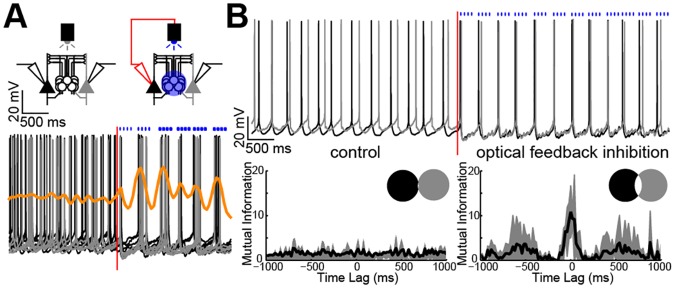
Type A PCs auto-synchronize via MCα2 inhibition.(A) Coupling one PC (black) out of two unconnected type A PCs to the light source/optical feedback inhibition system shows unsynchronized activity before and synchronized APs during optical feedback inhibition. A total of 24 PC discharges pairwise aligned to the first PC AP with optical feedback inhibition are shown (n = 24 cells; 12 black and 12 grey spike trains). Kernel density estimates (orange) highlight increased (peaks) and decreased (valleys) co-occurrence of APs. Note that the time points of the blue light depend on the PC APs during the optical feedback inhibition and therefore vary between PC pairs. (B) Top: One pair of simultaneously recorded unconnected type A PCs (black and grey) showing discharges before and during the optical feedback inhibition. Bottom: Pairwise mutual information index versus time lag from recordings in (A) showing low mutual information for unconnected PCs and high mutual information around 0-ms lag for PCs coupled by optical feedback inhibition (n = 12 dual recordings, 24 cells). Inset: Amount of overlap in Venn diagrams (black and grey circles) shows low mutual information for unconnected (left) and significantly higher mutual information for coupled (right) PCs (p < 0.05, two-tailed Student’s paired t test). Values are shown in S9 Data.